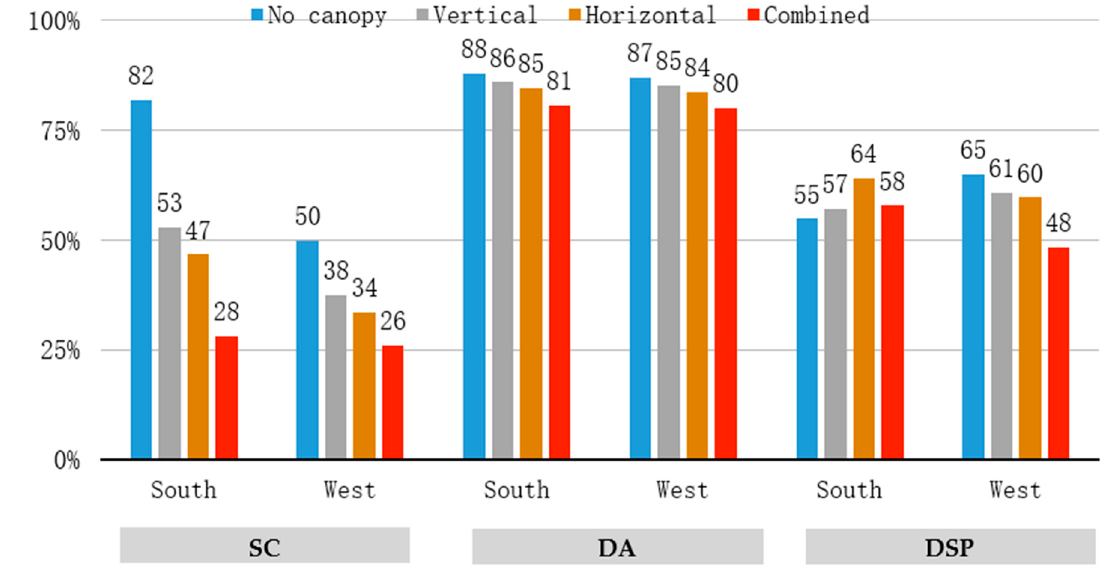
Figure 9. Comparison of daylight index with SC (Shading Coefficient), DA (Daylight Autonomy), and DSP (Daylight Saturation Percentage).